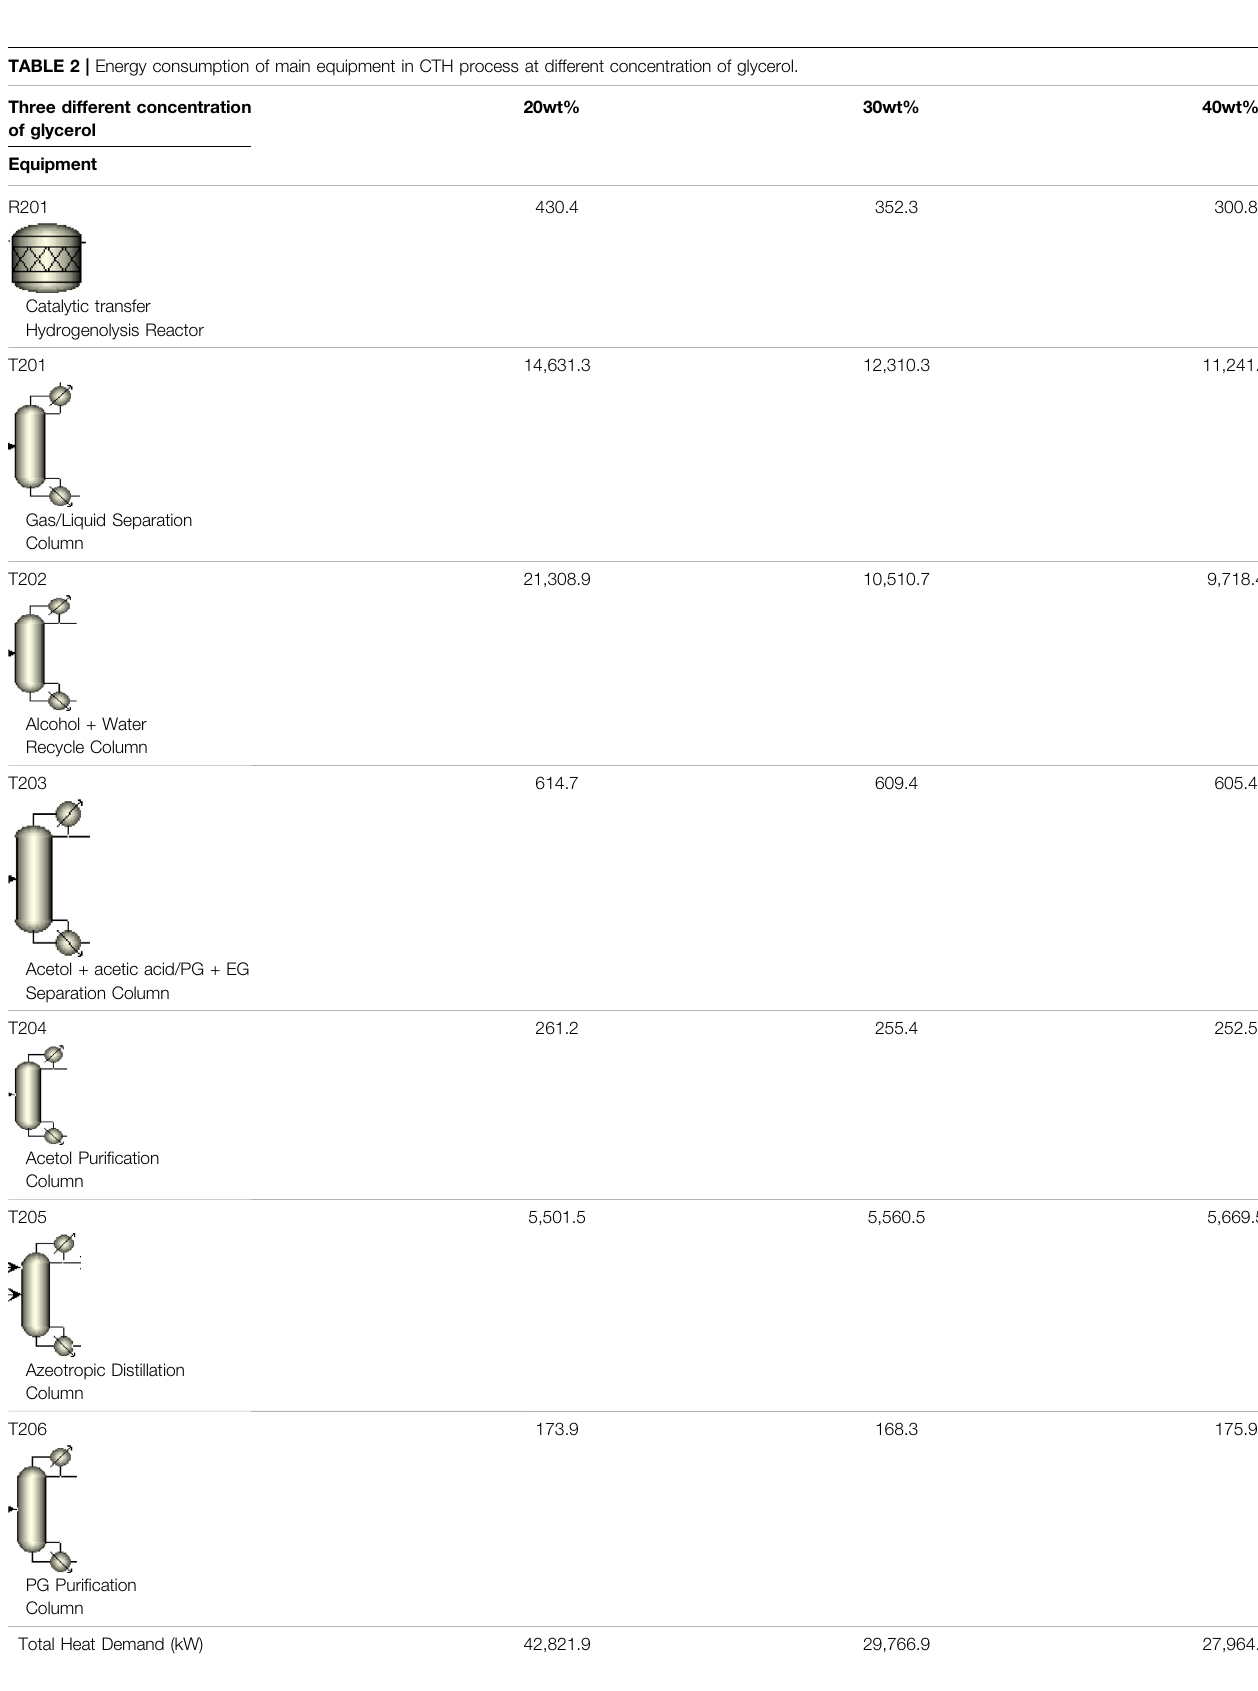
TABLE 2 | Energy consumption of main equipment in CTH process at different concentration of